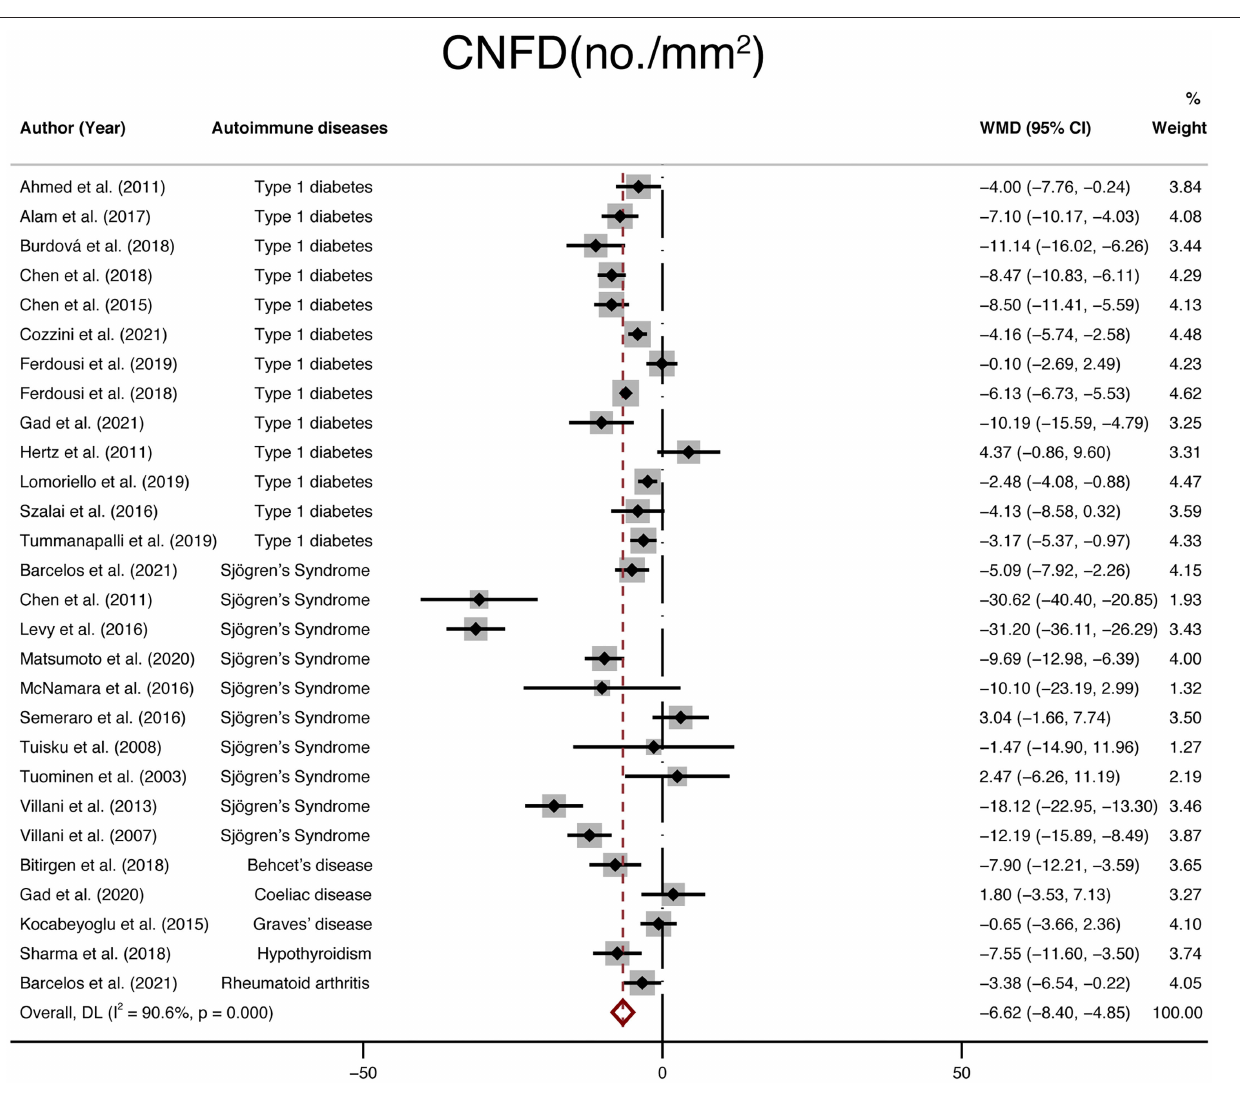
FIGURE 5 | Forest plot of the WMD of CNFD between the NNAI group and the control group. WMD, weighted mean difference; CI, confidence interval; CNFD, corneal nerve fiber density; NNAI, non-neurological autoimmune